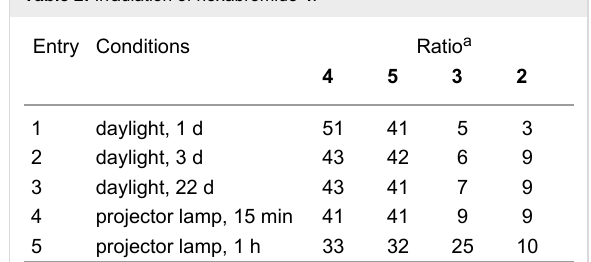
Table 2: Irradiation of hexabromide 4